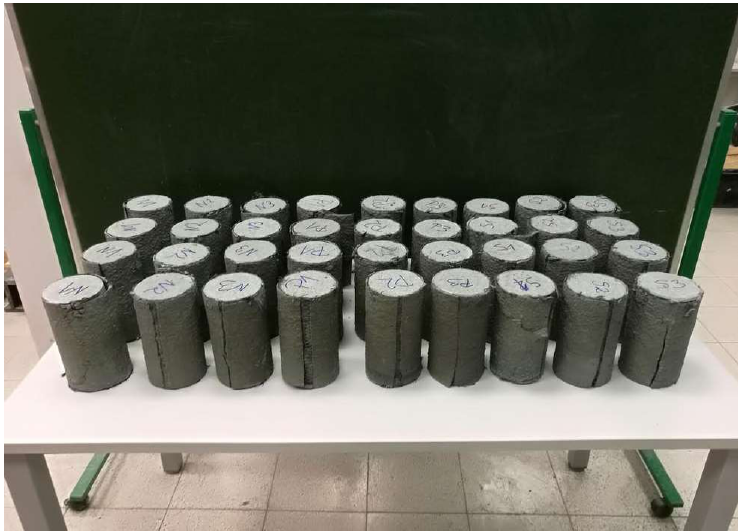
Figure 9. Concrete samples reinforced with carbon fibers using a cement matrix—state after the failure tests.